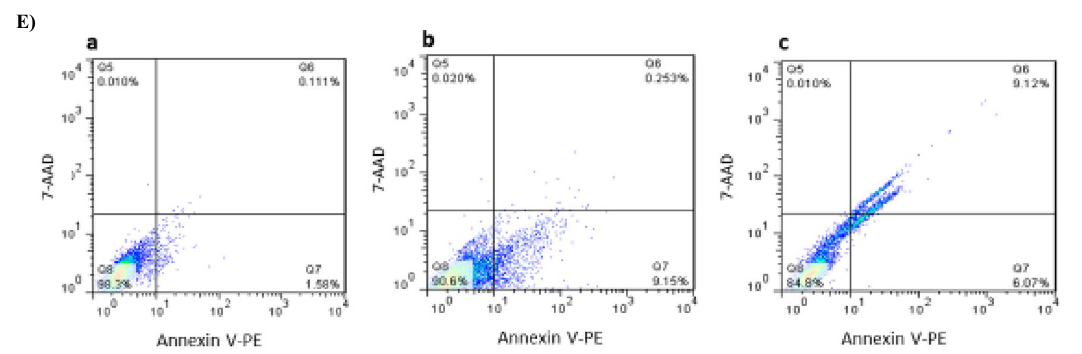
Figure 6. In vitro biocompatibility, cytotoxicity and apoptosis inducing activity of [FA-PEGylated/PEI@ GuIL@ KIT-6], siRNA@[FA-PEGylated/PEI@GuIL@KIT-6] and carboplatin. ( A) and (B ) MDA-MB-231 and MCF- 10A cell viability after 24 and 48 h treatment with different concentrations of [FA-PEGylated/PEI@GuIL@ KIT-6], respectively. ( C) and (D ) MDA-MB-231 cell viability under treatment of different concentrations of carboplatin and the cocktail of various concentrations of carboplatin plus consistent concentration of siRNA@ [FA-PEGylated/PEI@GuIL@KIT-6] after 24 and 48 h, respectively. (The concentration of siRNA was consistent and equal to 2.1 µM). ( E ) Flow cytometry analysis of MDA-MB-231 cells treated with carboplatin and siRNA@ [FA-PEGylated/PEI@GuIL@KIT-6]. Cells were stained with Annexin V-PE/7-AAD and quantitated by flow cytometry after 24 h of incubation. The cells treated ( a ) with PBS (negative control) ( b ) with IC 50 value of carboplatine and ( c ) cocktail of IC 50 value of carboplatin and siRNA@[FA-PEGylated/PEI@GuIL@KIT-6] equal to 2.1 µM siRNA. Data are given as the means ± SD. (n =